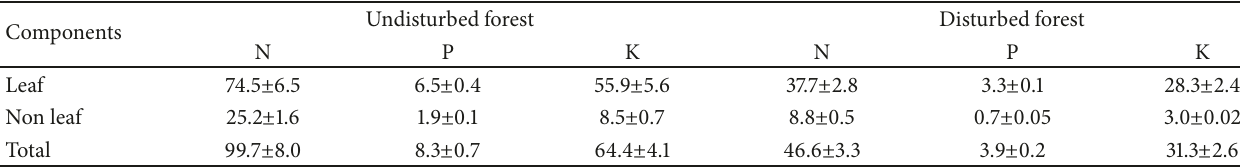
Table 8: Amount of nutrients (kg ha – 1 yr – 1 ) in litterfall in undisturbed and disturbed forest stands of moist tropical forest of Sunsari district, eastern Nepal (mean ± SE).